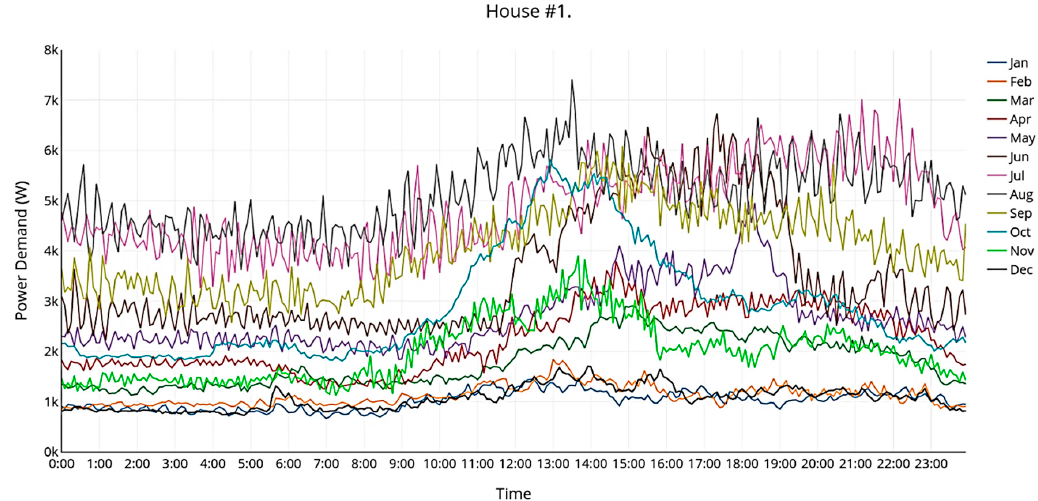
Figure 3. Investigation of time-resolution on excess energy. Five-min and 1-hour data sets are used for H1 using January 1 demand and photovoltaic (PV)-20 data.